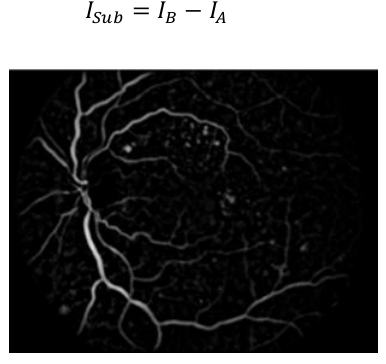
Fig. 6. The image result of subtraction process ( I Sub )